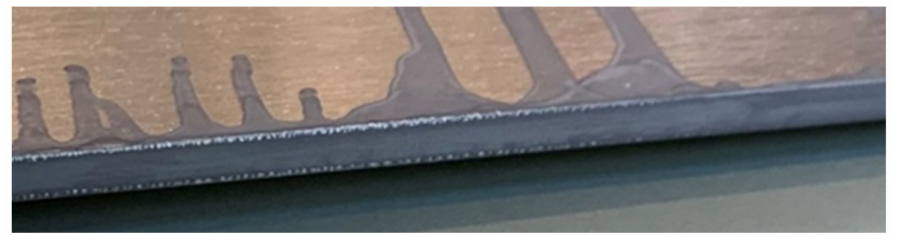
Figure 4. Joining partner with tungsten carbide.